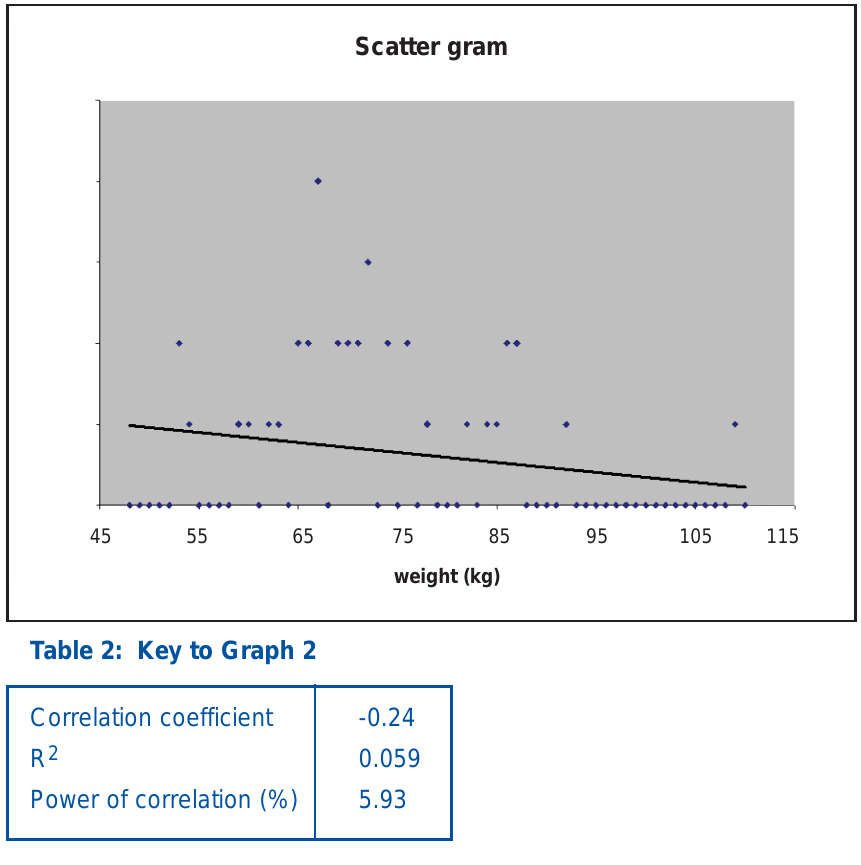
Graph 2: Weight versus Incidence of injury.